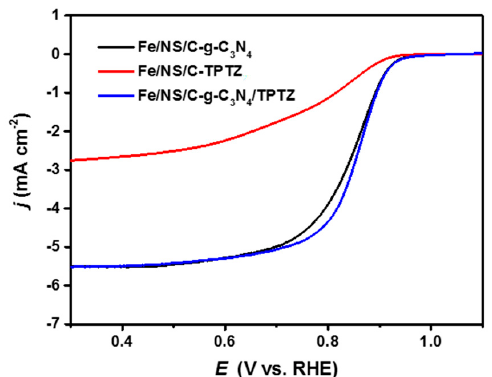
Figure 3. Oxygen reduction reaction (ORR) polarization curves of Fe/NS/C ‐ g ‐ C 3 N 4 , Fe/NS/C ‐ TPTZ, and Fe/NS/C ‐ g ‐ C 3 N 4 /TPTZ catalysts in O 2 ‐ saturated 0.1 M KOH with a rotating speed of 1600 rpm and at a scan rate of 10 mV s − 1 . RHE: reversible hydrogen electrode.